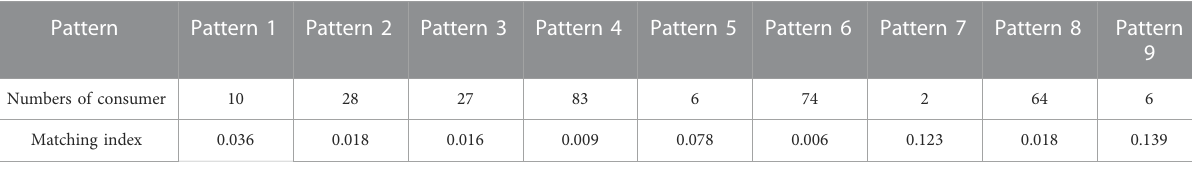
TABLE 1 Pattern matching results on November